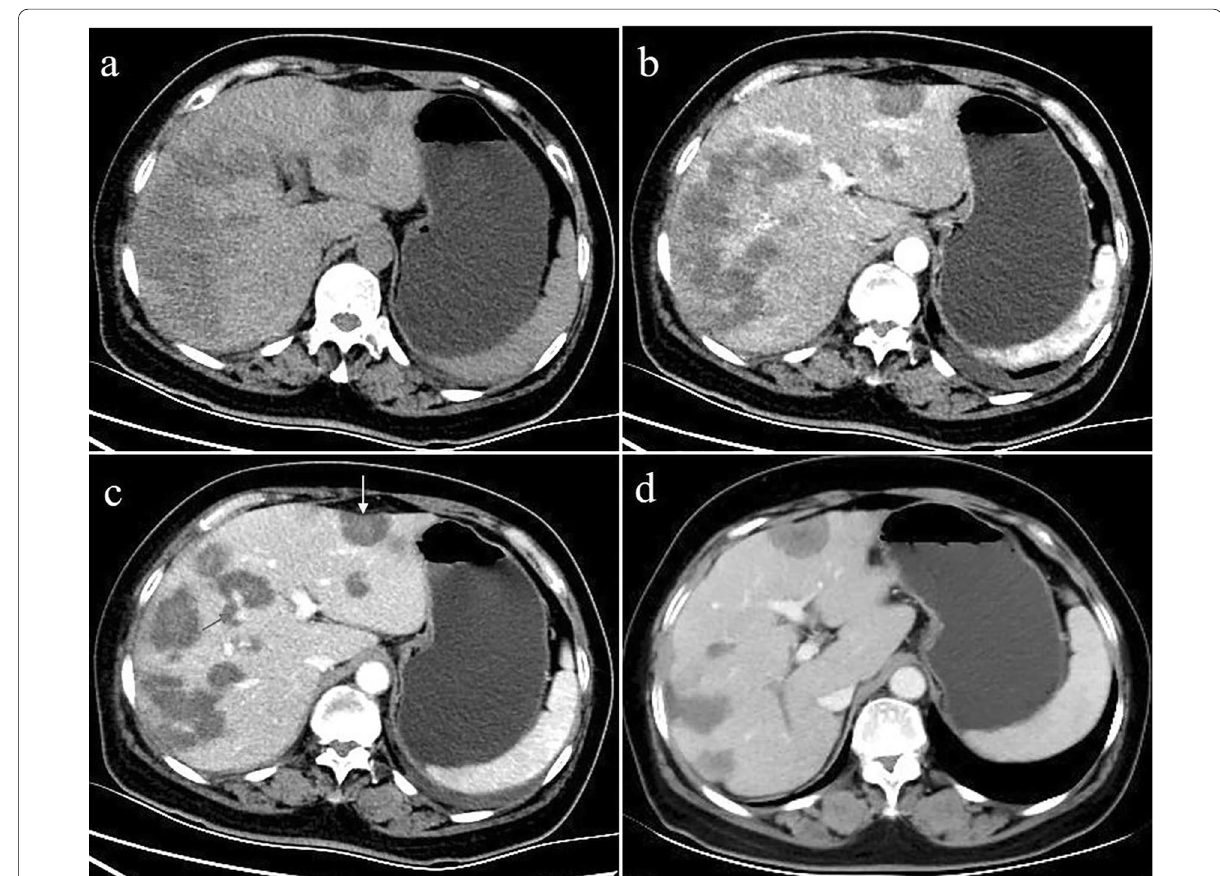
Fig. 6 A 52-year-old female with diffuse nodular type HEH. Axial unenhanced CT images ( a ) show diffuse coalescing hypoattenuating lesions. Arterial phase CT images ( b ) show slight enhancement, and some nodules confluent to strip-like or snowmelt are located subcapsularly in the liver. In the portal phase ( c ), the lesions are not progressively enhanced, a small branch of the portal vein is seen passing through the middle of the lesions (red arrow), and capsular retraction (yellow arrow). On follow-up CT performed 10 months after radiofrequency ablation, axial portal